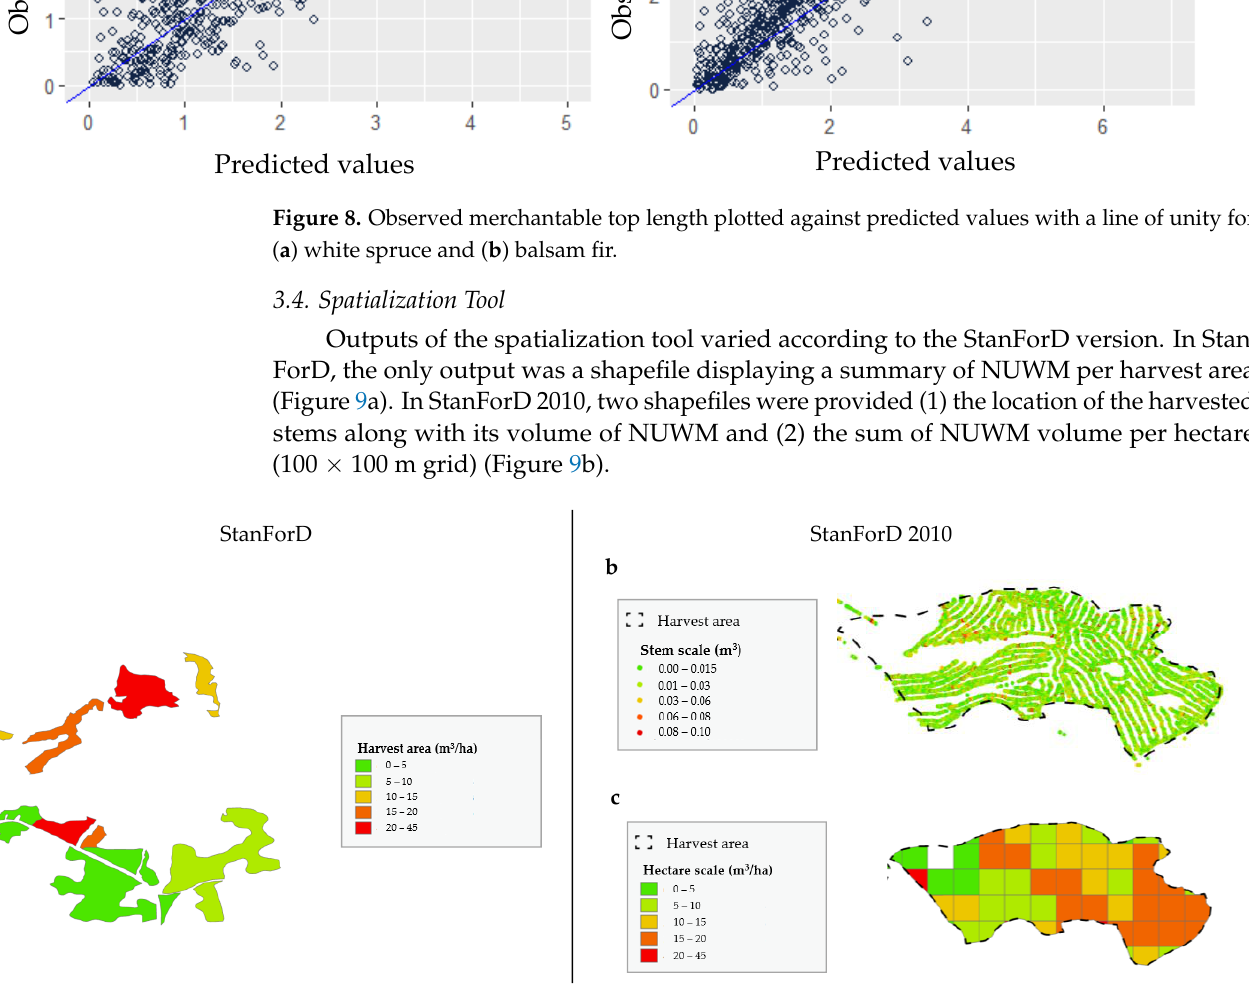
Table 5. Summary of exploratory comparison of technical aspect.